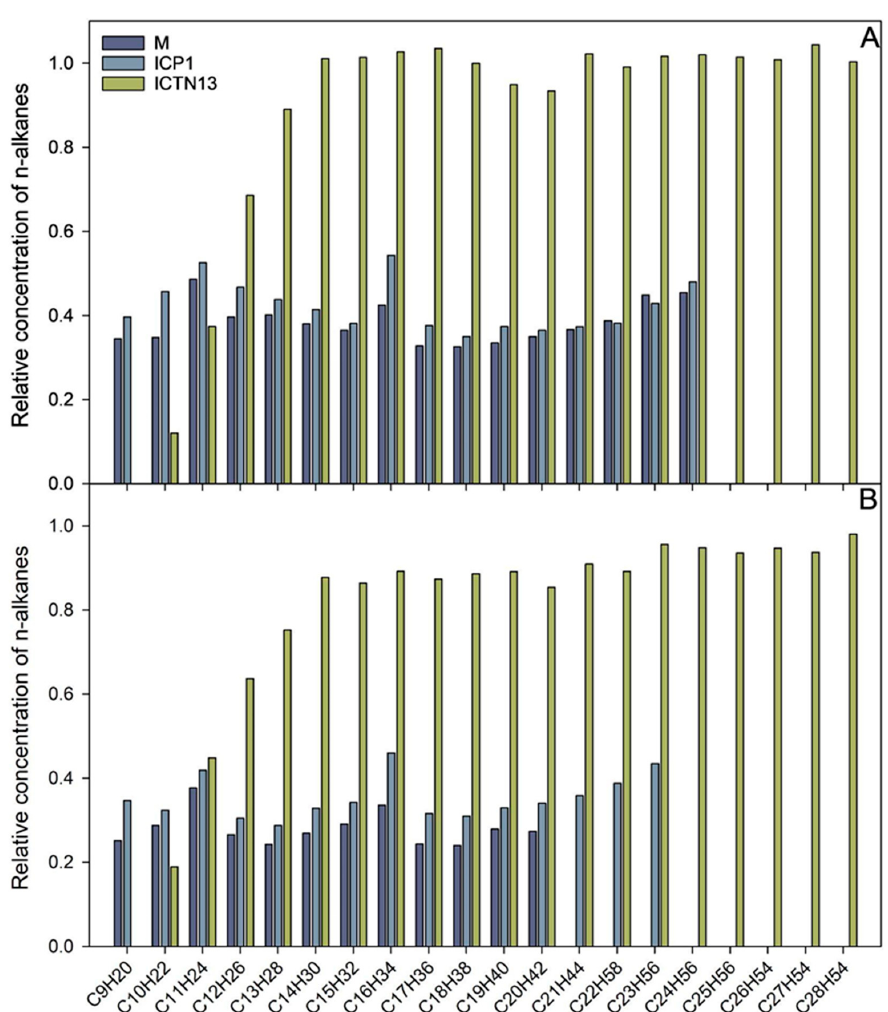
Figure 3. The relative concentration of n-alkanes after 24 h ( A ) and five days ( B ) incubation of A. venetianus strain ICP1 and P. oleovorans strain ICTN13 and the mixture of the strains (M) in M9 minimal medium containing 1% crude oil at 30 ◦ C. The content of n-alkanes in the samples is expressed as the relative concentration compared to the abiotic control.